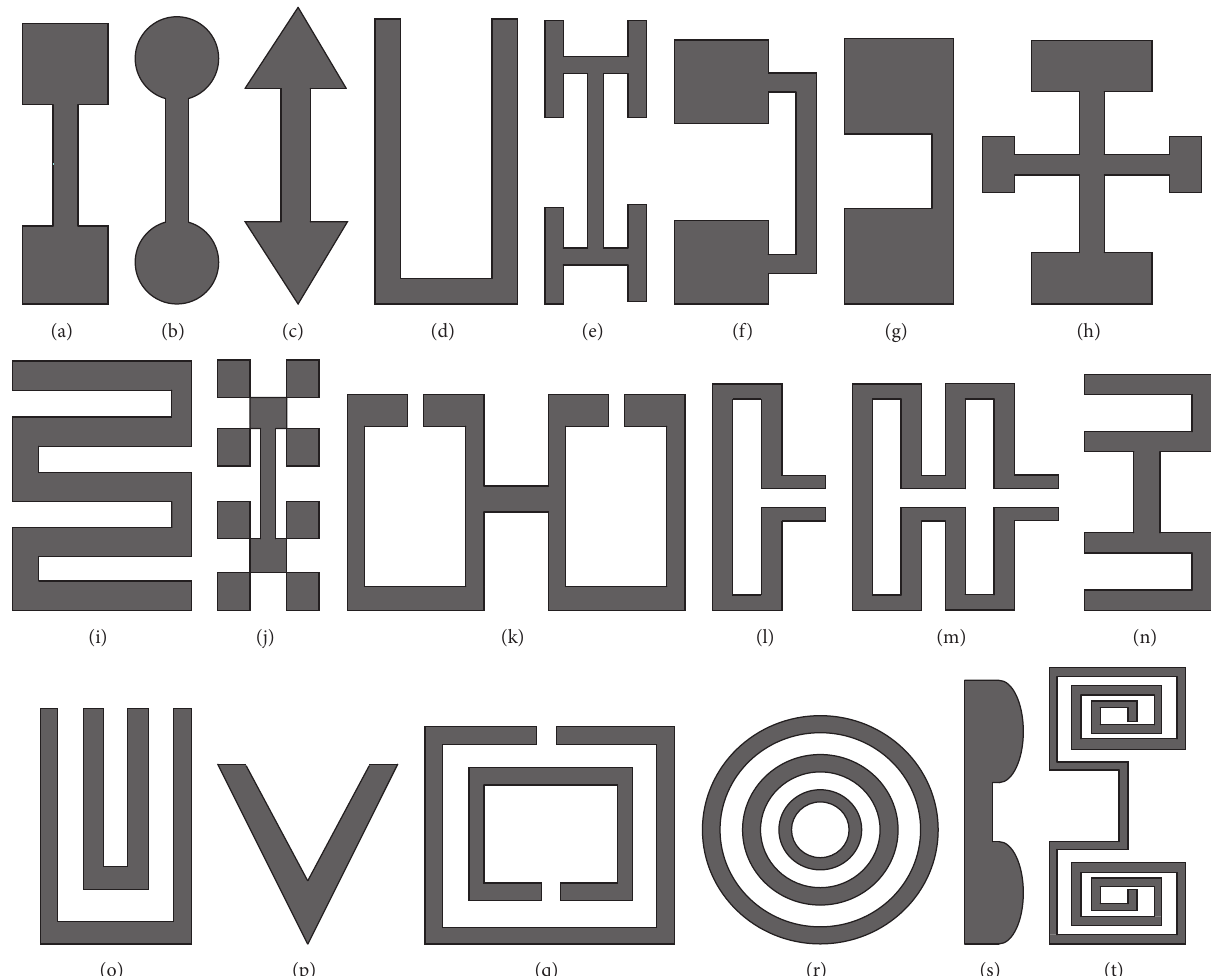
Figure 23: Some of the most common DGS structures employed in the applications [78]. (a) Dumbbell-shaped, (b) circular head dumbbell, (c) arrow head dumbbell, (d) U-shaped, (e) H-shaped, (f) squared heads connected with U-slots, (g) squared slots connected with narrow slot at edge, (h) cross-shaped, (i) interdigital, (j) fractal, (k) open loop dumbbell, (l) L-shaped, (m) meander lines, (n) U-head dumbbell, (o) double equilateral U, (p) V-shaped, (q) split-ring resonators, (r) concentric ring shaped, (s) half-circle, and (t)